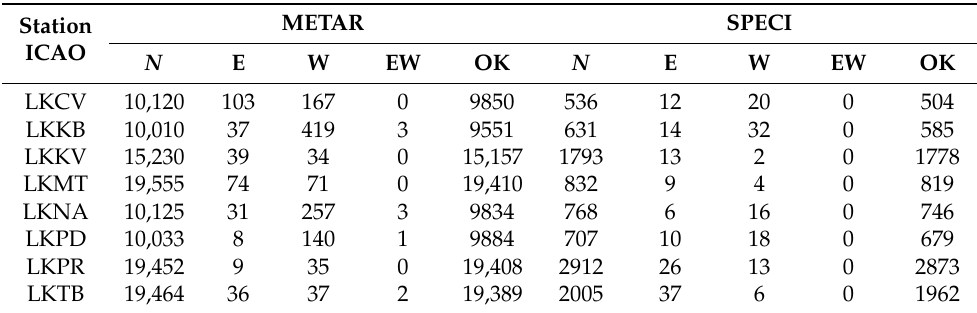
Table 6. Overview of the total numbers of reports and ERROR (E) and WARNING (W) errors in METARs and